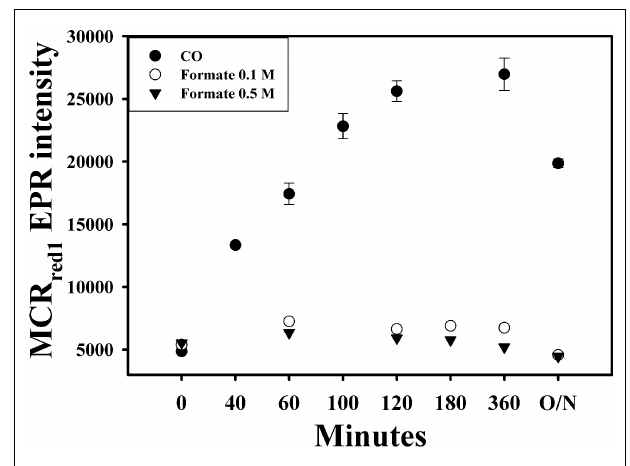
FIGURE 5 | In vivo activation of MCR with CO (filled circles), 0.1 M formate (open circles), and 0.5 M formate (triangles). O/N,